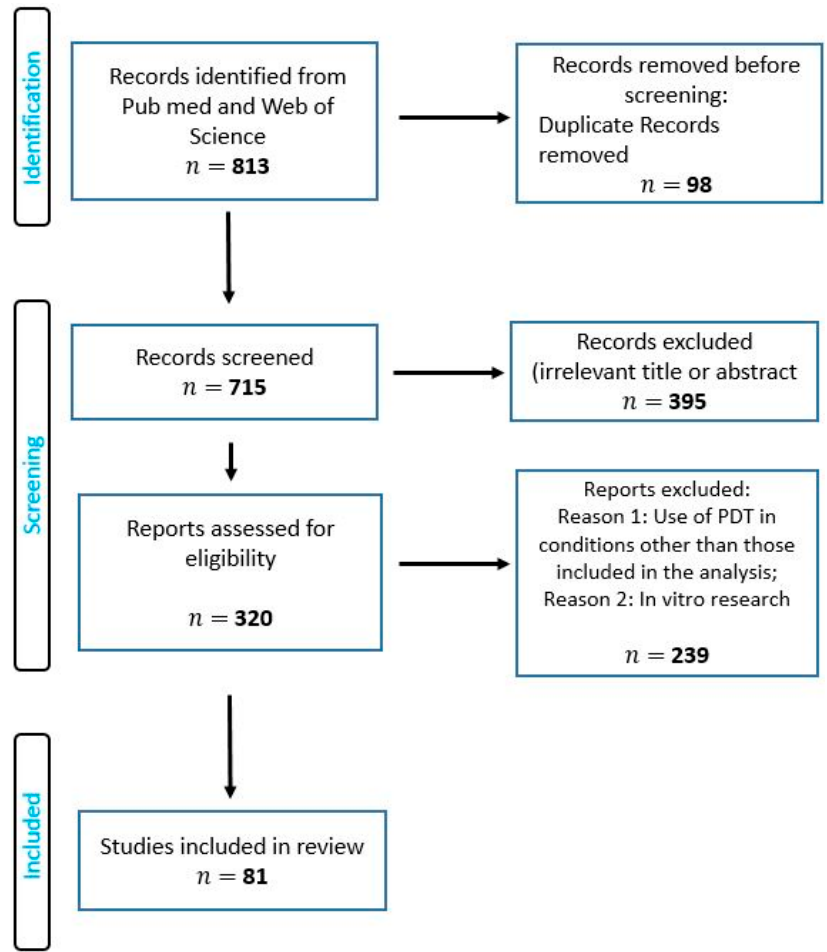
Figure 3. Diagram illustrating the procedure for analyzing the source